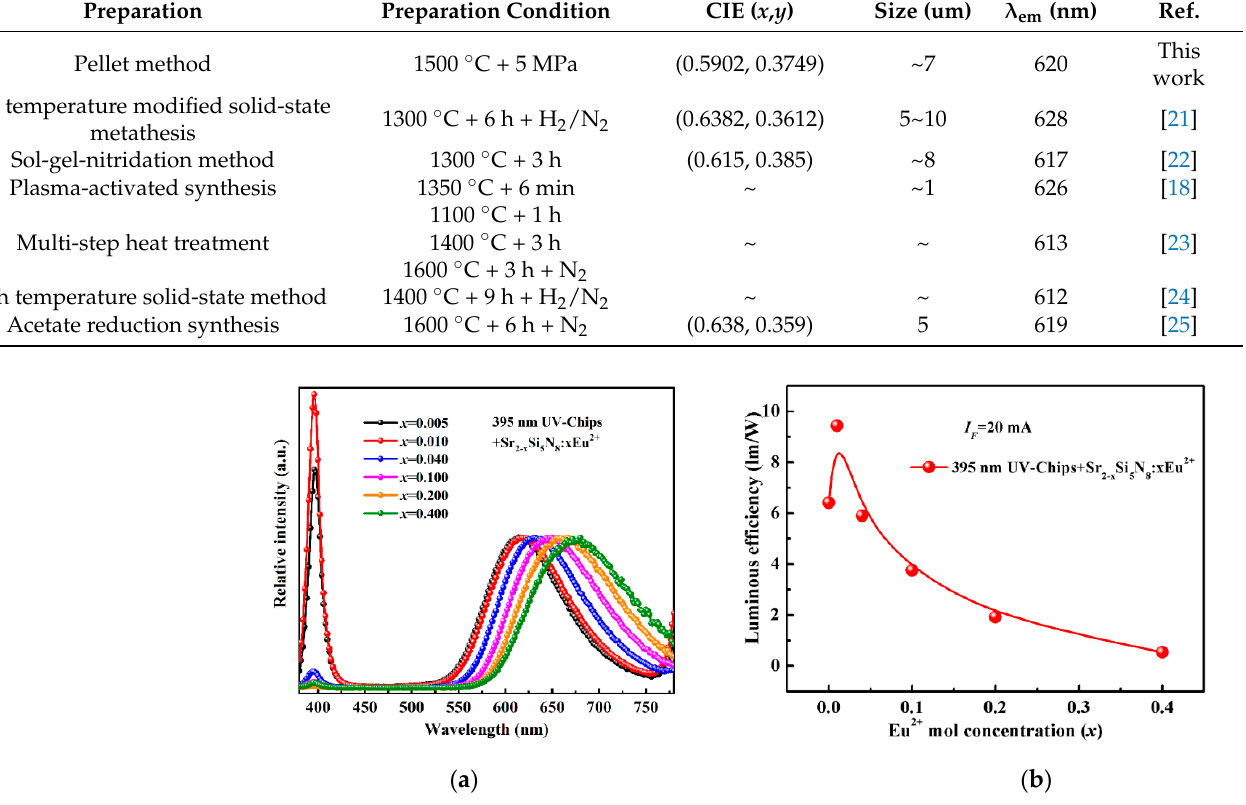
Figure 8. ( a ) Electroluminescence spectra of the as-fabricated LEDs based on 395 nm UV-chip and Sr 2 − x Si 5 N 8 : x Eu 2+ phosphors under 20 mA forward-bias current; ( b ) luminous efficiency of as-fabricated LEDs with different Eu 2+ concentration ( x ) under I F = 20 mA. Table 2. The chromaticity coordinates of the as-fabricated LED based on 395 nm UV-chip and